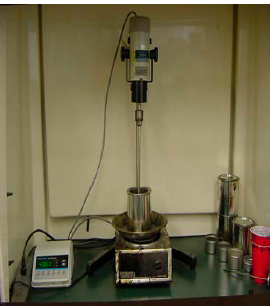
Figure 2. Mechanical mixer for stirring base asphalt with graphene platelets.